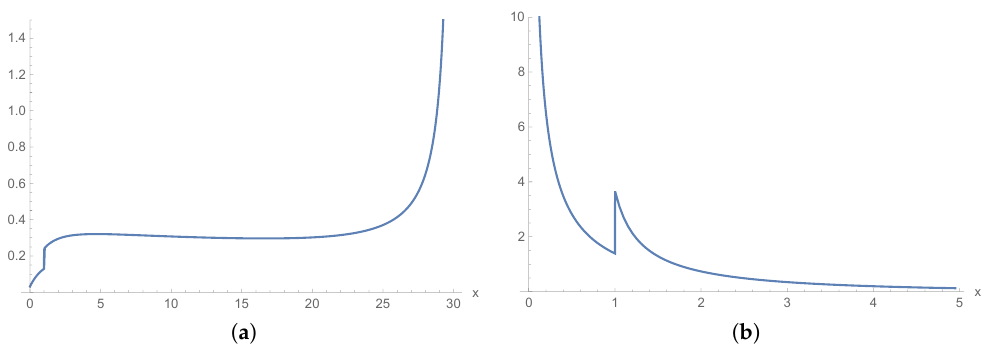
( Y ) as functions of x , with u = 1 ms, u , t